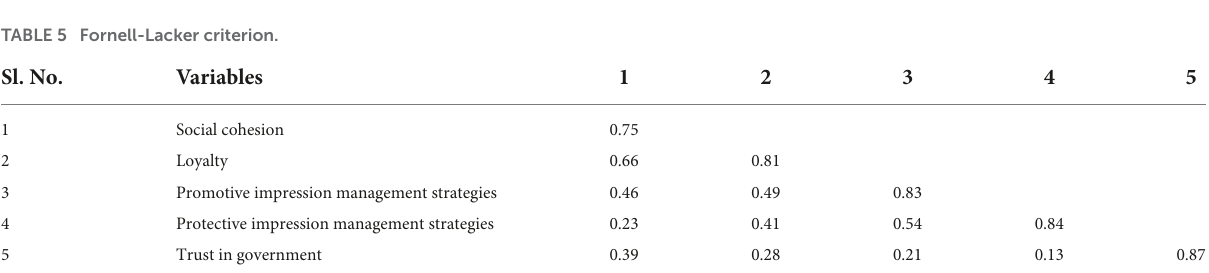
TABLE 5 Fornell-Lacker